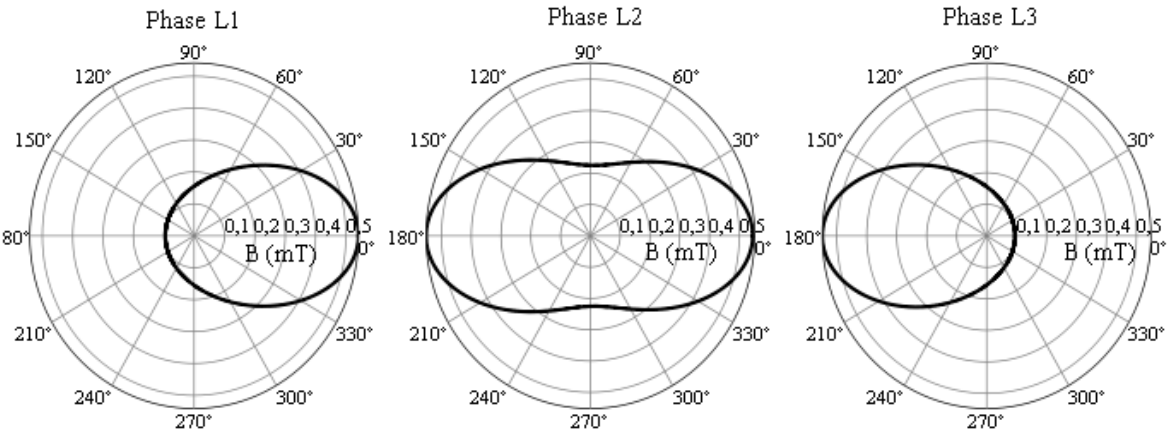
Figure 4. Distribution of the RMS values of the total magnetic flux density at the field points of the observational circles positioned outside each of the phases of the busduct